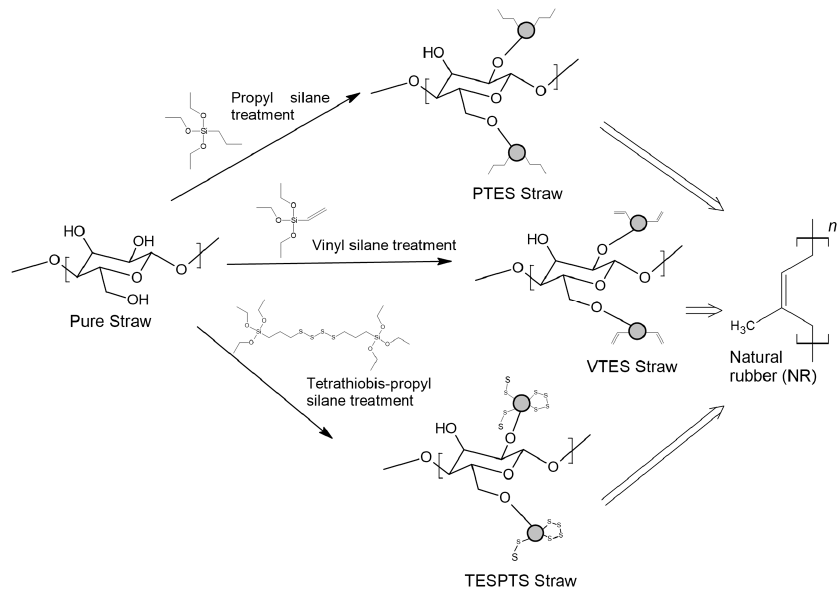
Figure 1. The reaction schemes of silane treatments.